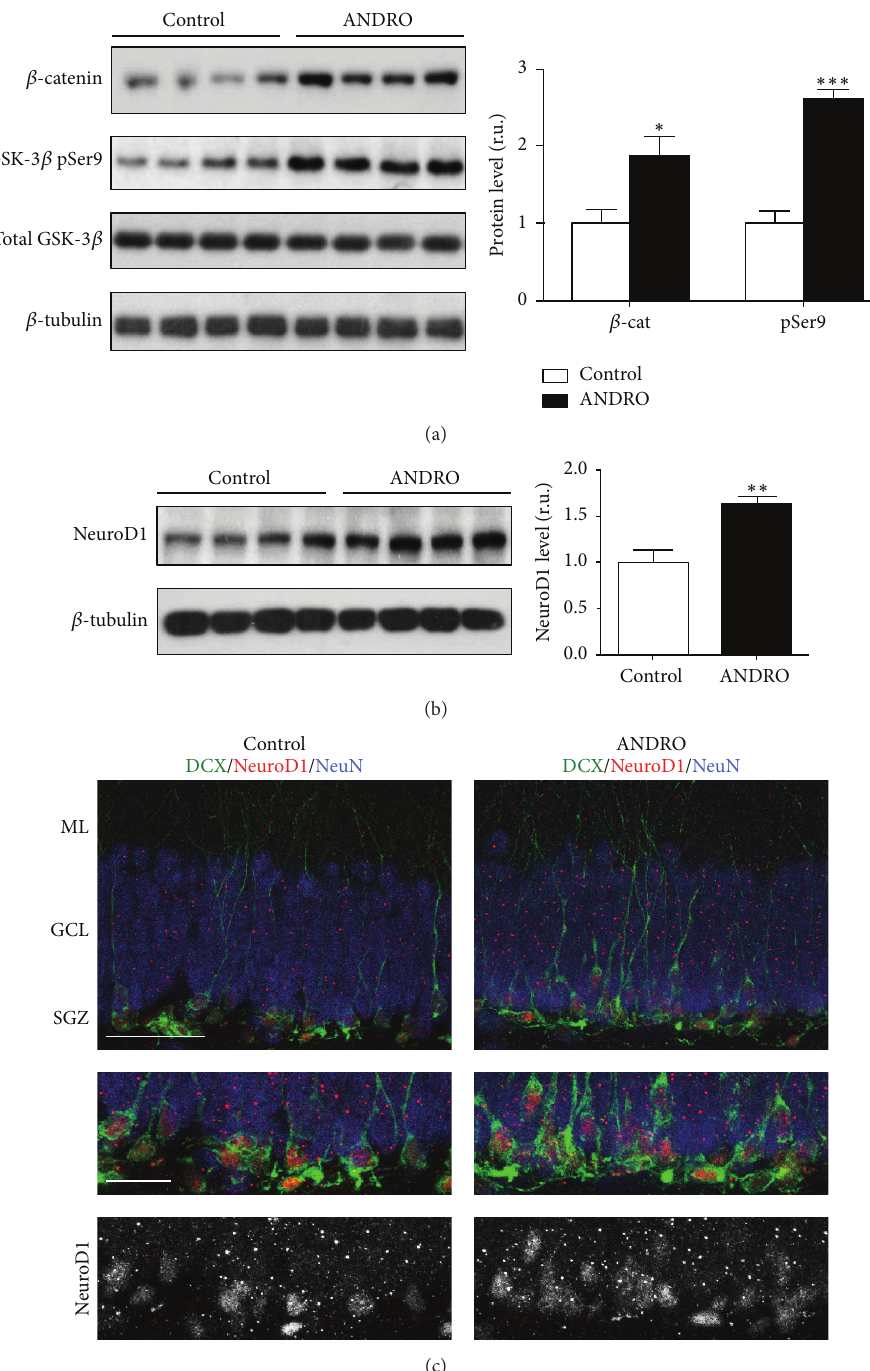
Figure 5: ANDRO induces the activation of the Wnt signaling pathway in the hippocampus of adult mice. (a) Immunoblots of 𝛽 -catenin, inactive form of GSK-3 𝛽 (phosphorylated in serine-9, pSer9), total GSK-3 𝛽 , and 𝛽 -tubulin used as loading control in total protein extracts obtainedfromthehippocampusof2-month-oldmiceinjectedi.p.with2 mg kg −1 ANDROorvehicleascontrol3timesaweekfor4weeks.The graph corresponds to the densitometric analysis of 𝛽 -catenin and GSK-3 𝛽 pSer9 normalized to 𝛽 -tubulin and total GSK-3 𝛽 , respectively. (b) Immunoblot of NeuroD1 and 𝛽 -tubulin. The graph corresponds to the densitometric analysis of NeuroD1 normalized to 𝛽 -tubulin level. (c) Representative immunostaining of NeuroD1, DCX, and NeuN in mice treated with vehicle or ANDRO for 4 weeks. Scale bar: 20 𝜇 m. Bottom, higher magnifications of the images. Scale bar: 20 𝜇 m. Bars represent mean ± S.E. ( 𝑛 = 4 mice). ∗ 𝑃 < 0.05 , ∗∗ 𝑃 < 0.01 , and ∗∗∗ 𝑃 < 0.001 , Student’s 𝑡